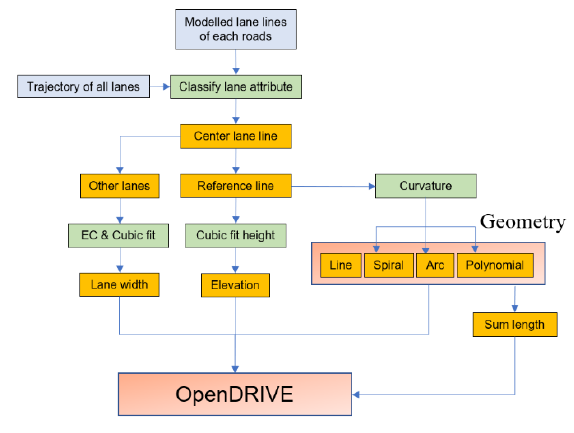
Figure 5. The flowchart of generating OpenDRIVE